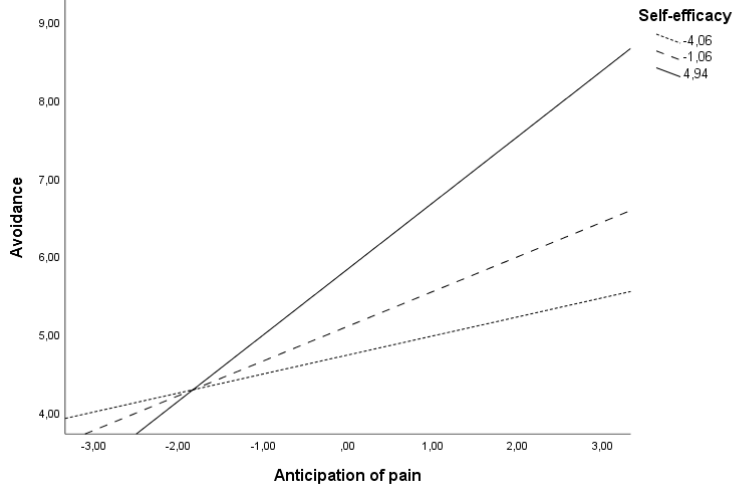
Figure 3. In individuals with high levels of self-efficacy, pain anticipation will directly and significantly predict patient ´ s avoidance. In subjects with lower levels of self-efficacy, pain anticipation is independent of avoidance during treatment.